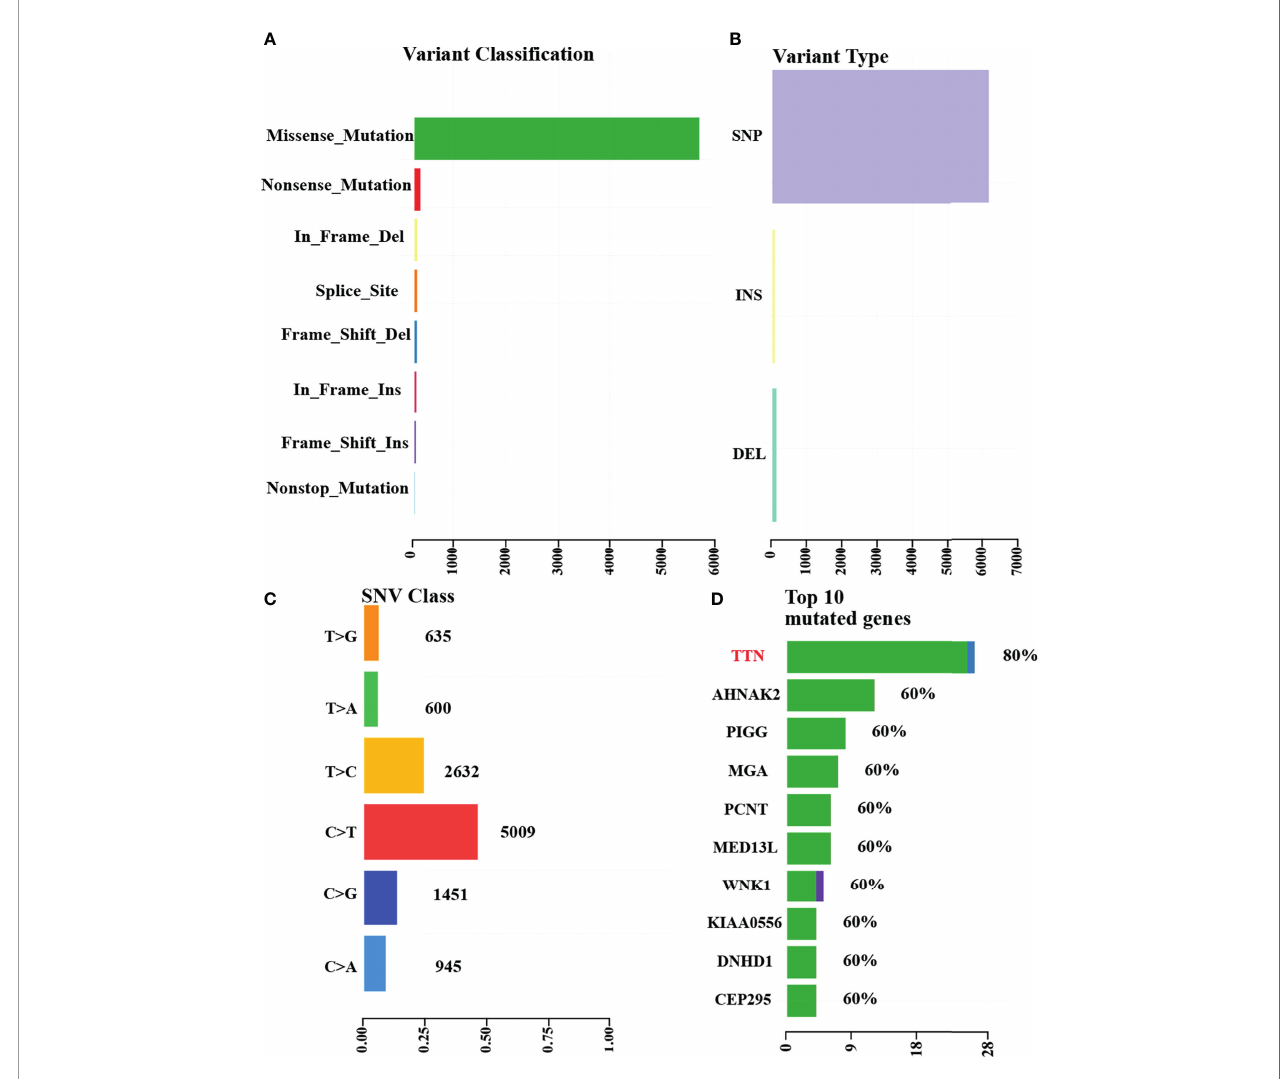
FIGURE 3 | WES identi fi ed variants and top mutated genes in the fi ve ACSCC patients. (A) Variant classi fi cations. (B) Variants types. (C) SNV class. (D) Top 10 mutated genes. The green, blue and purple color was de fi ned as missense_mutation,frame_shift_del and frame_shift_ins, respectively, in Figure 3D